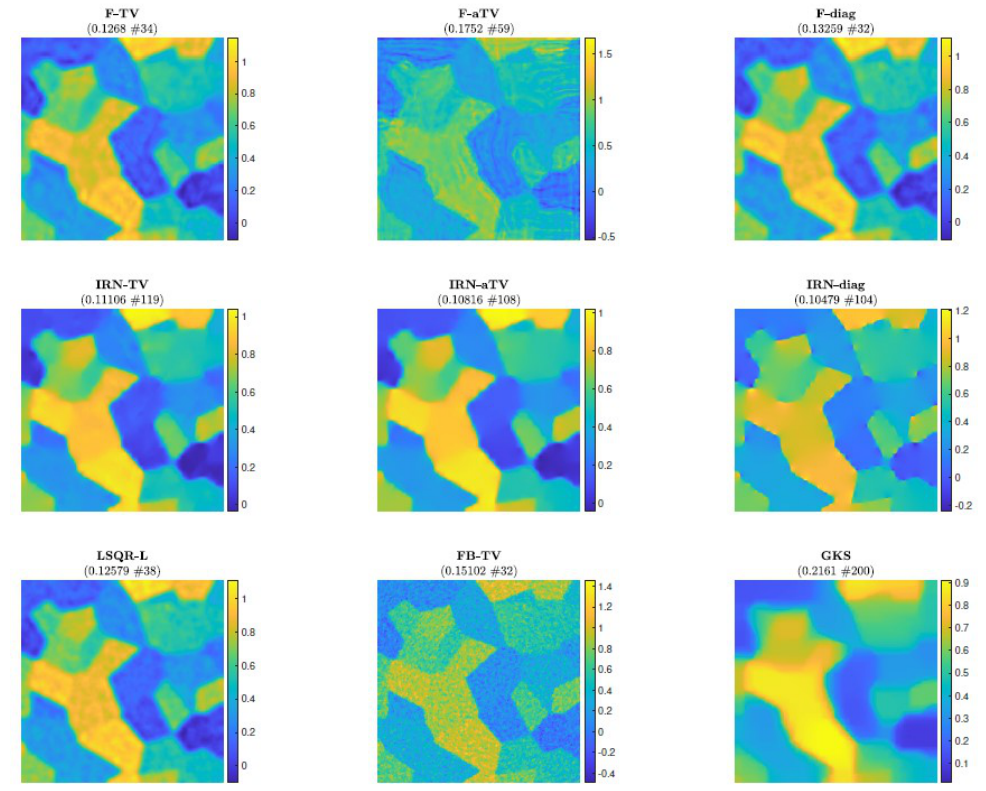
Figure 11. Experiment 3. Reconstructions achieved by various methods. The RRE and corresponding stopping iteration are displayed in the frame